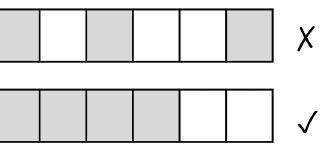
Figure 4. Continuous pixel marking (edge detection).